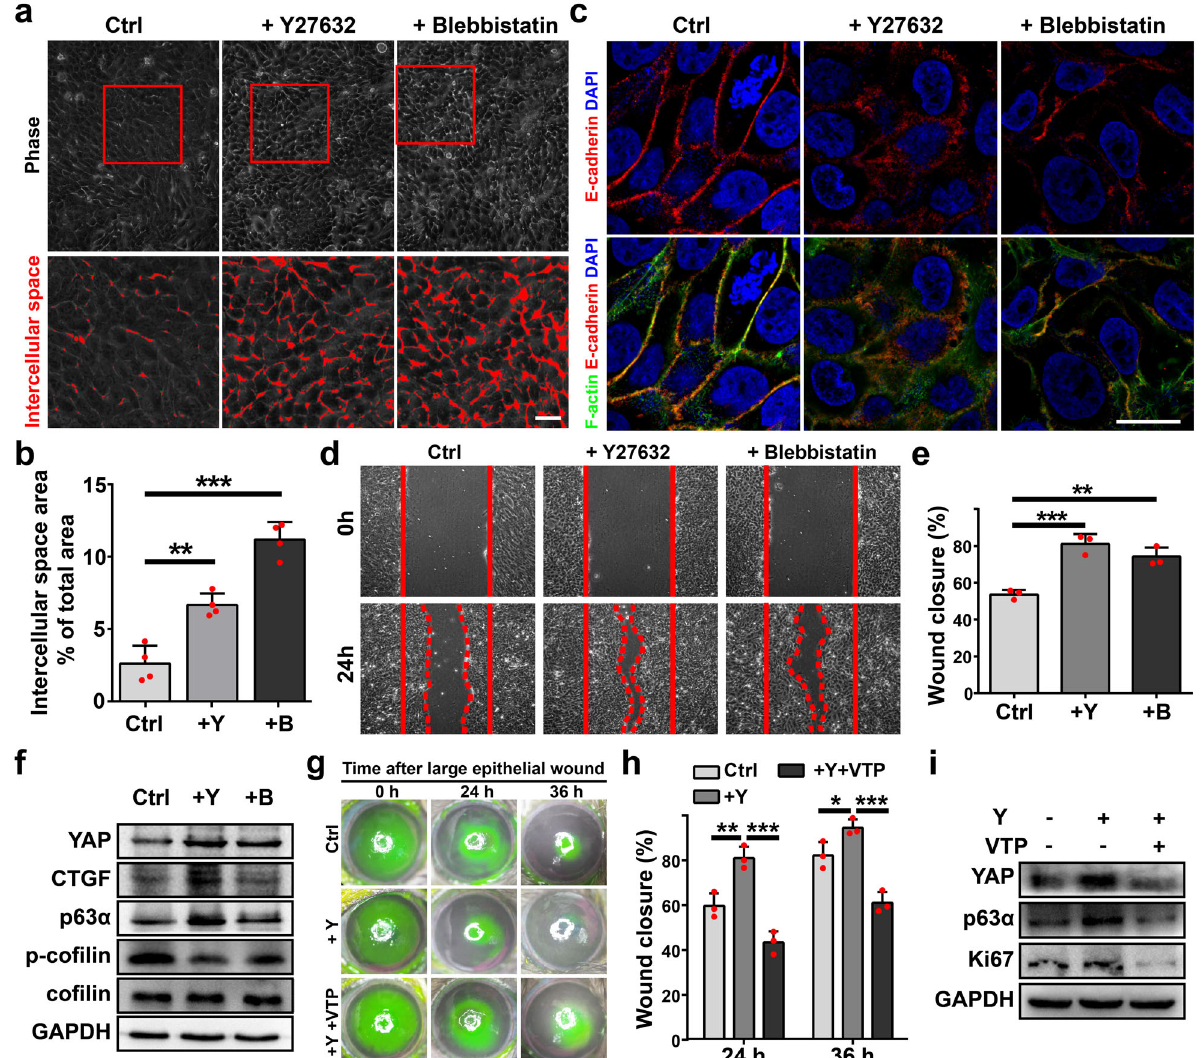
Fig. 5 Manipulating F-actin cytoskeleton regulates YAP activity. a , b Intercellular spaces between hCECs under indicated treatments for 8 h, and quanti fi cations of intercellular spaces between hCECs. c E-cadherin and fl uorescein-phalloidin stainings of hCECs under indicated treatments for 8 h. d , e hCECs cells are scratch wounded at con fl uence, and images are captured at 0 and 24 h post-scratching. Quanti fi cations of wound closure (%) at 24 h post-scratching. f Western analysis of indicated proteins from hCECs cells under indicated treatments for 24 h. g , h The corneal epithelial defects are stained with fl uorescein sodium at 0, 24, and 36 h after 4 mm-diameter wound under indicated conditions. Quanti fi cations of wound closure (%) at 24 and 36 h. i Western blotting analysis of indicated proteins from rabbit primary cultured LESCs cells under indicated treatments for 24 h. Scale bars, 20 μ m ( a , c ). Data are the mean ± SD, n = 4 biological replicates ( b ), n = 3 biological replicates ( e ), n = 3 corneas ( h ); * p < 0.05, ** p < 0.01, *** p < 0.001; One-way ANOVA with Dunnett ’ s post test ( b , e ) or Student ’ s two-tailed unpair e d t -test ( h ). Ctrl, 0.1% DMSO; Y27632, 20 μ M ( a – c ) or 10 μ M ( d – i ); Blebbistatin, 30 μ M ( a – c ) or 20 μ M ( d – f ); VTP, 10 μ M ( g , h ) or 5 μ M ( i